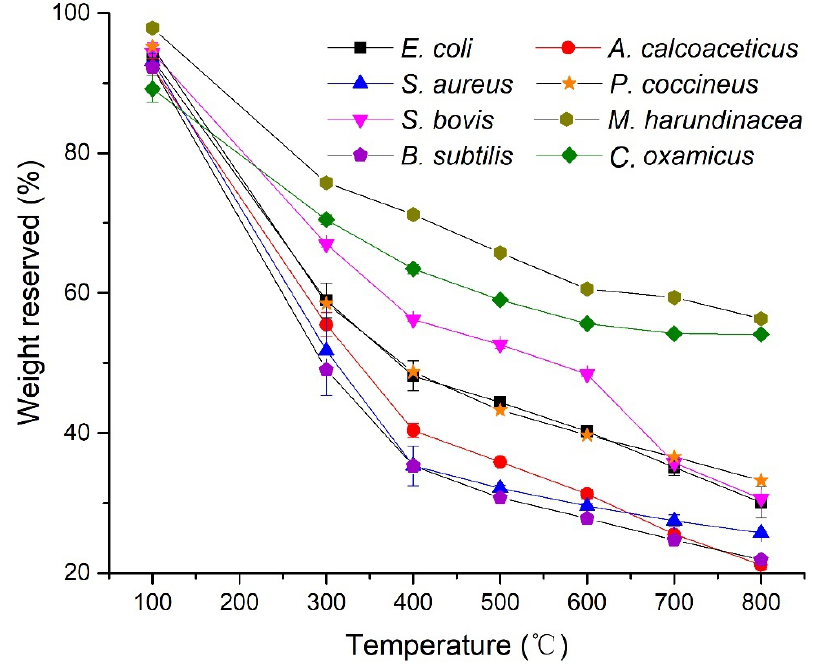
Figure 1. Weight-loss of the eight microbial strains by TGA pyrolysis at different